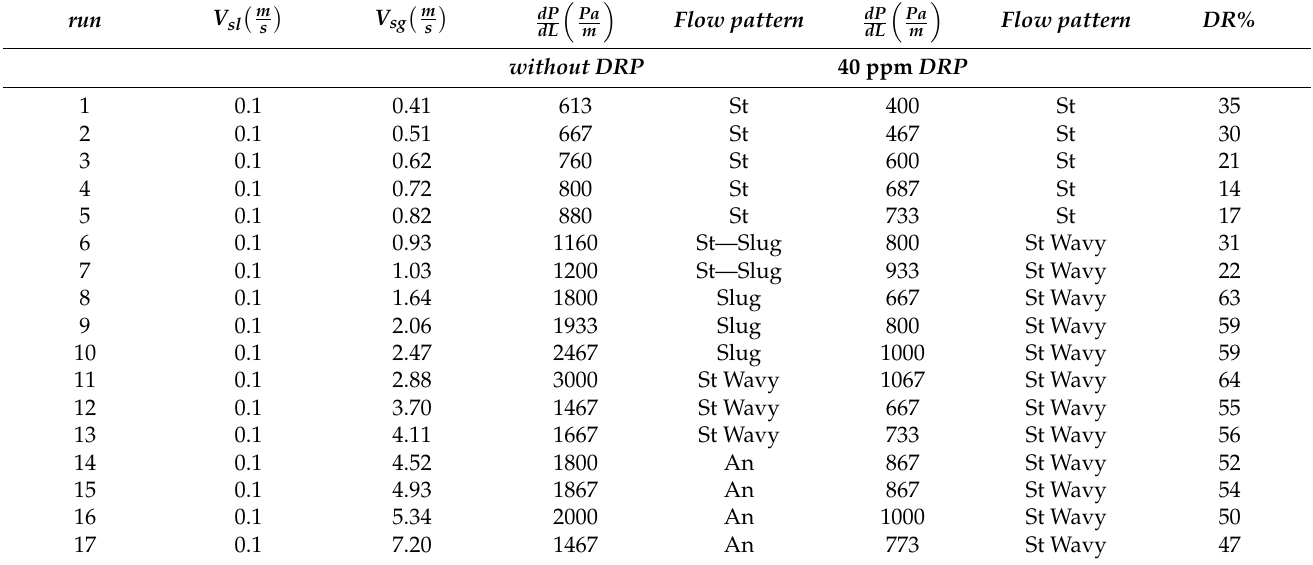
Table A1. Frictional Pressure Drop and Flow Pattern with and without 40 ppm